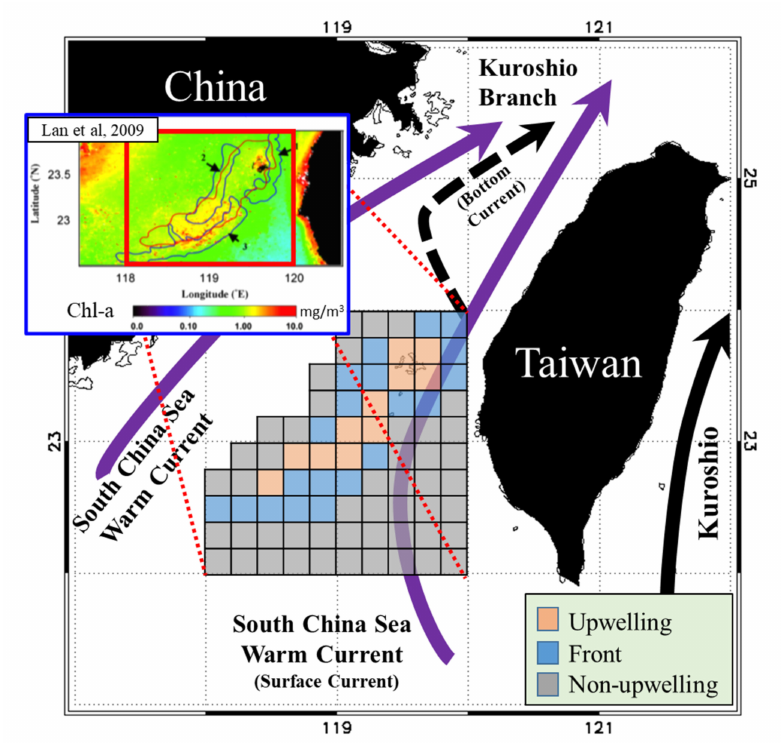
Figure 1. Schematic of currents and three studied habitat types in the Taiwan Bank. The orange, blue, and gray boxes represent the upwelling, thermal front, and non-upwelling habitats, respectively. High PP contributes to abundant fishery resources. The upwelling of nutrient-rich bottom water into the euphotic zone promotes the growth and propagation of phytoplank- ton, sustaining zooplankton communities and generally supporting fishery